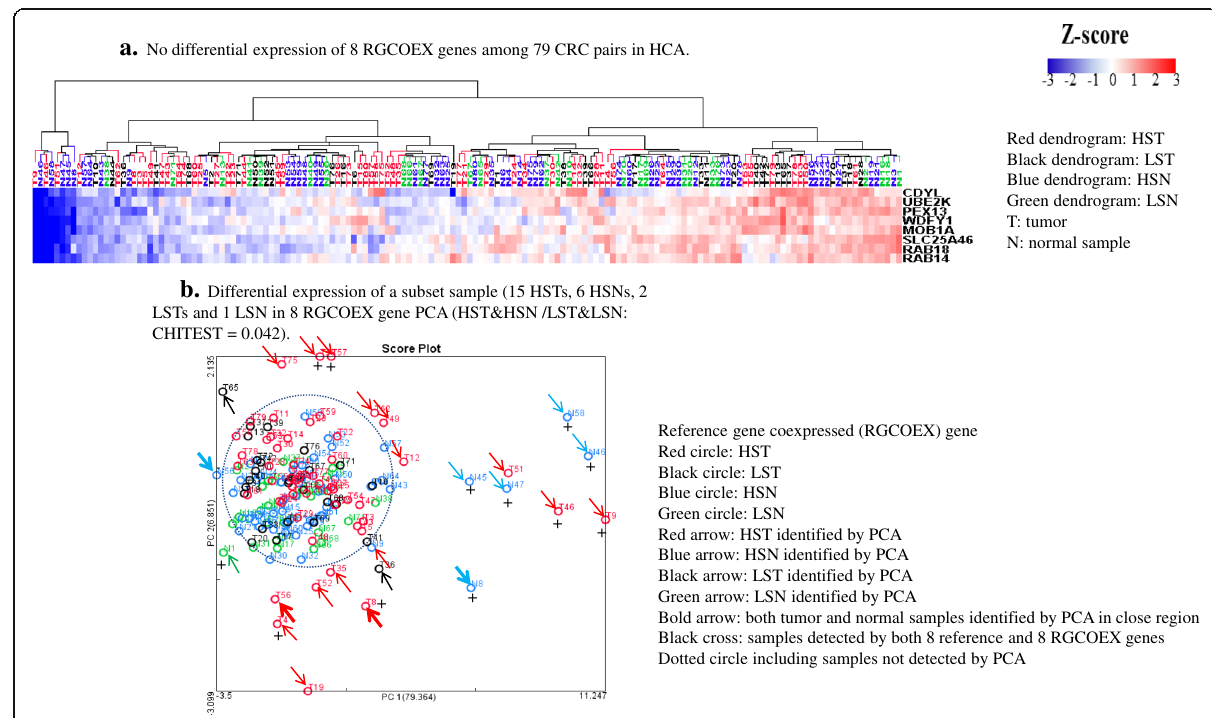
Fig. 4 HCA and PCA analysis of 8 RGCOEX genes in 79 CRC pairs. a . No differential expression of 8 RGCOEX genes among 79 CRC pairs in HCA. b . Differential expression of a subset sample (15 HSTs, 6 HSNs, 2 LSTs and 1 LSN in 8 RGCOEX gene PCA (HST&HSN /LST&LSN: CHITEST = HSTs and HSNs compared to 26 LSNs (Additional file 1: Figure S4a, S4b).